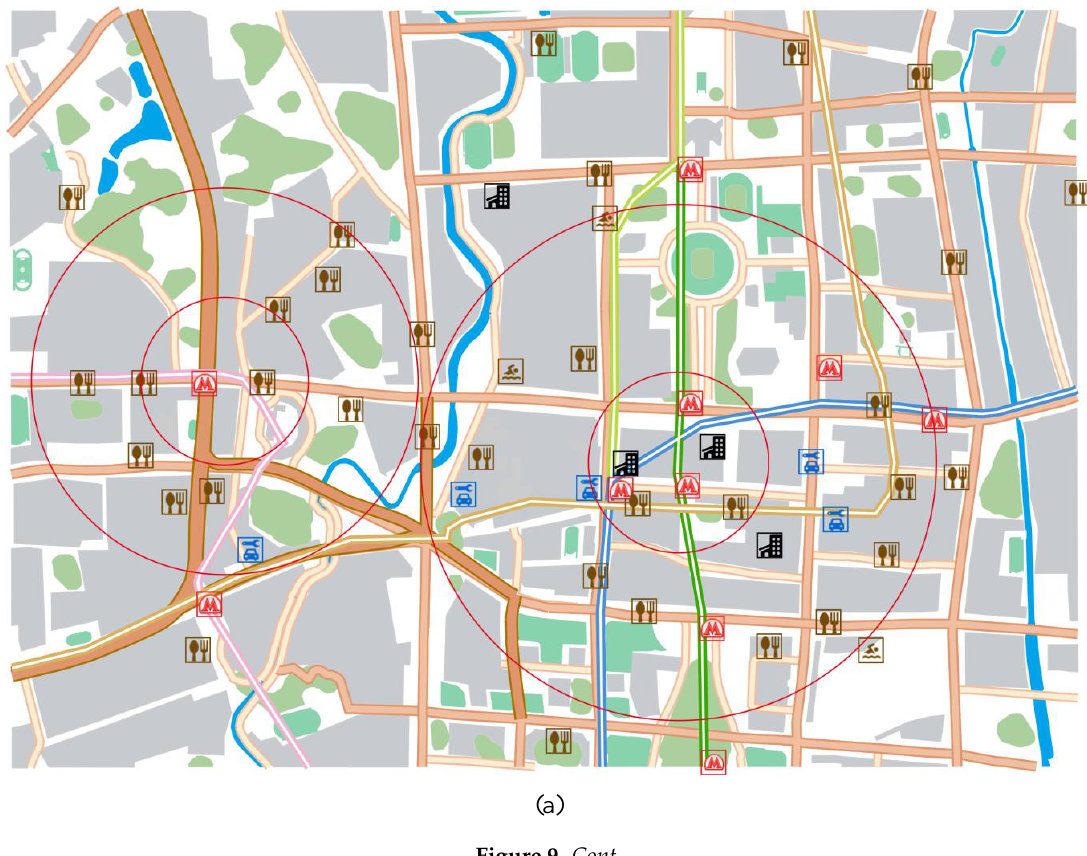
Figure 8. The variable-scale map with a focus area: ( a ) fixed-scale representation; ( b ) variable-scale representation and the shape of the focus area is a circle; ( c ) variable-scale representation and the size of the focus area is smaller; ( d ) variable-scale representation and the shape of the focus area is